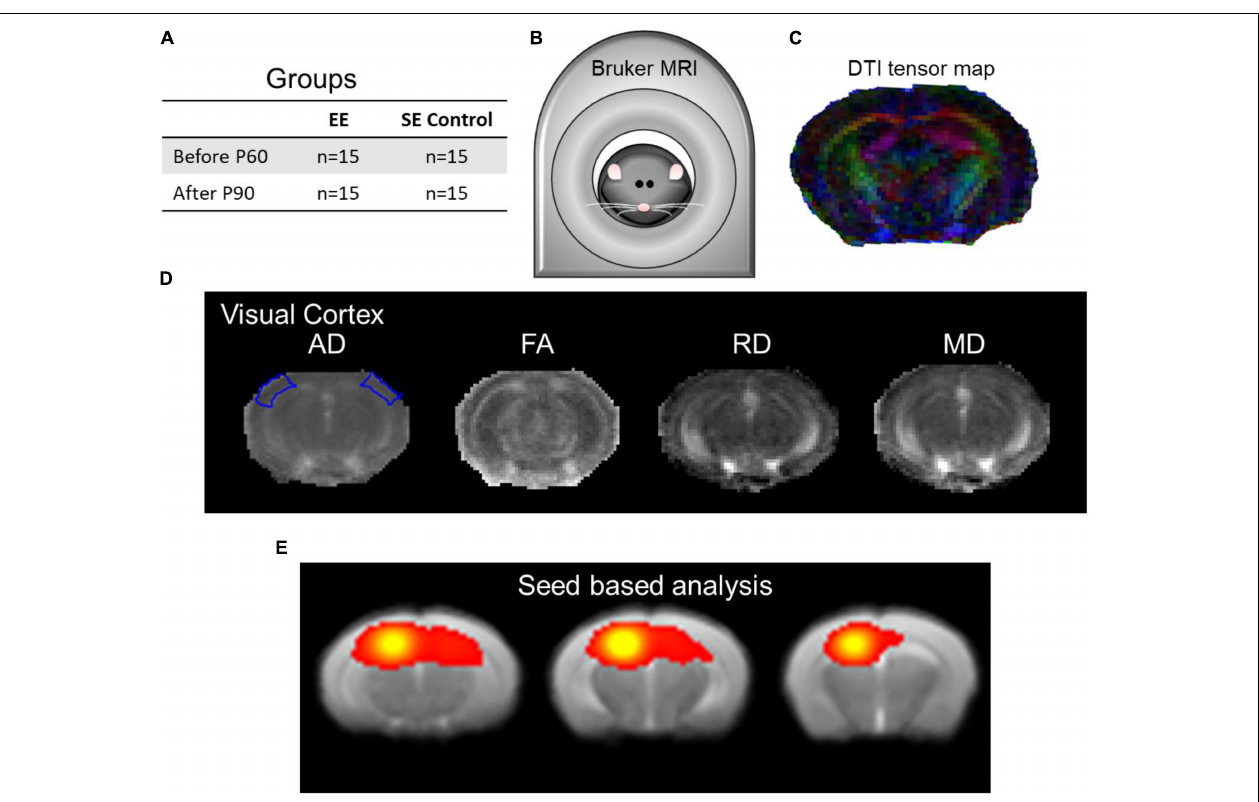
FIGURE 1 | The experimental design setup and data analysis. (A) Enriched environment (EE) and standard environment (SE) control groups were assessed using structural and functional MRI. (B) Bruker BioSpec 7T scanner with the putative mouse inside. (C) Demonstrative DTI tensor color map. (D) DTI indices maps (AD, FA, RD, and MD) of the visual cortex at approximately Bregma AP-2.8/–2.9 (Franklin and Paxinos, 2008, Figure 54/55). (E) Seed-based analysis (SBA) of local connectivity outlining the hippocampal complex as part of rsfMRI (approximately Bregma AP-3.25/–2.50/–1.75 corresponding to Franklin and Paxinos, 2008, Figures